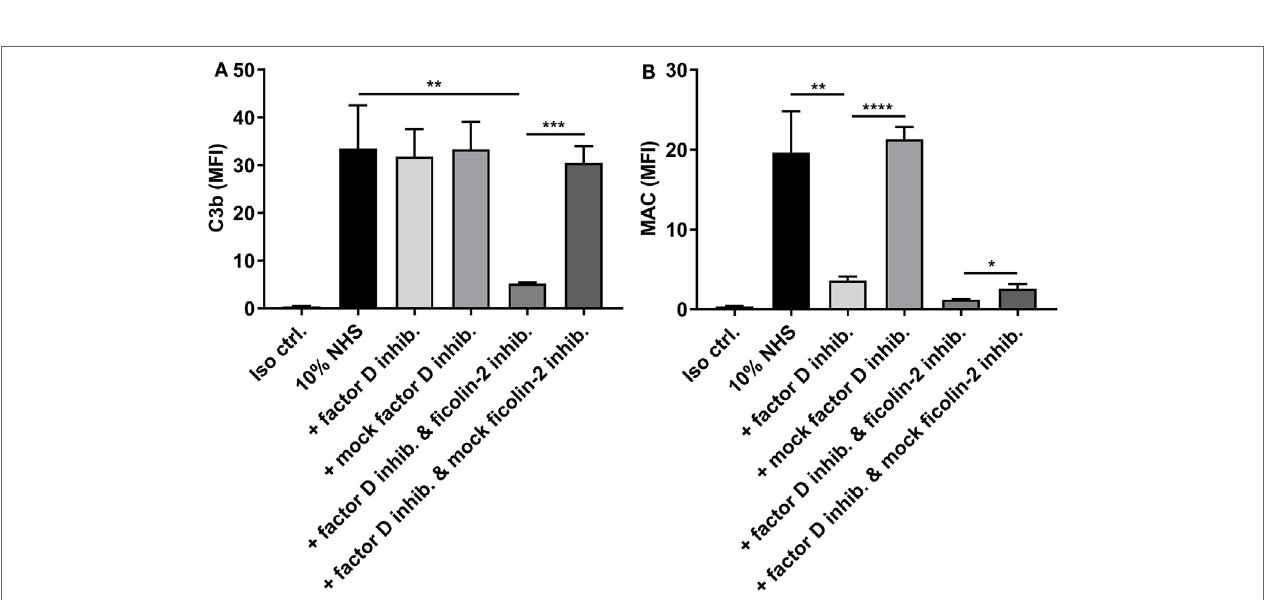
FigUre 8 | Inhibitory effects of a factor D inhibitor on C3b, and membrane attack complex (MAC) deposition. 10% normal human serum (NHS) was combined with a factor D inhibitor (5 µg/ml) and incubated with isolate C322-17. Detection was done with specific biotinylated monoclonal antibodies against (a) C3b and (B) MAC, followed by FITC-conjugated Streptavidin. Complement deposition was measured by flow cytometry and expressed as mean fluorescence intensity (MFI). Results represent the means of three independent experiments ± SD, * p ≤ 0.05, ** p ≤ 0.01, *** p ≤ 0.001, **** p ≤ 0.0001 (unpaired Student’s t -test).